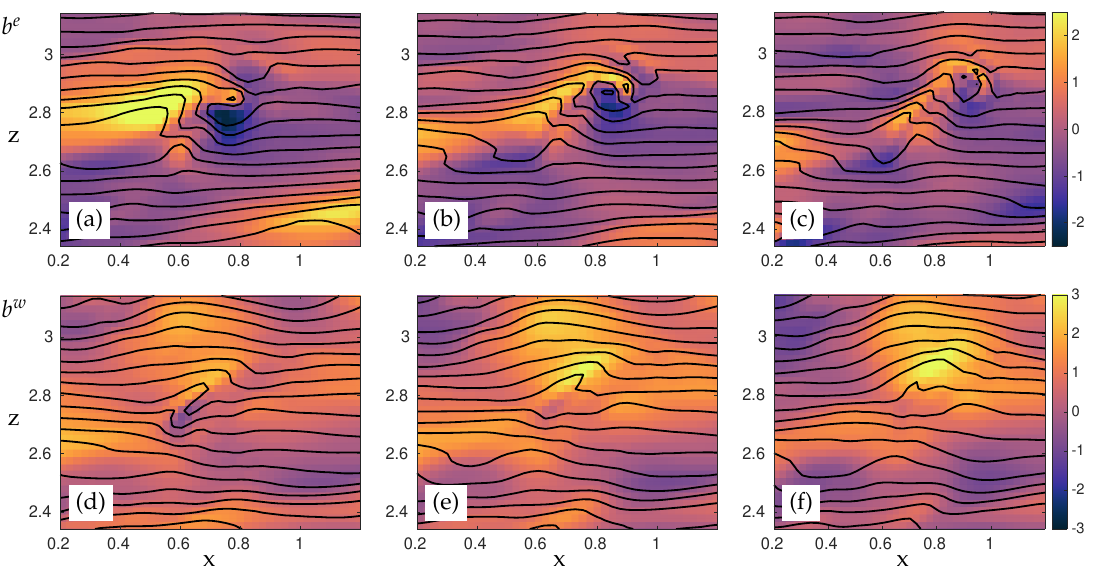
Figure 15. Distribution of buoyancy in the ( x , z ) plane in the middle of the y interval (zoom in). The images are separated by the same time gap 3 ∆ t (cid:48) = 0.15. Superimposed iso-density lines are in black. The first line ( a – c ) is the eddy part of the wave-eddy decomposition and the second line ( d – f ) is the wave